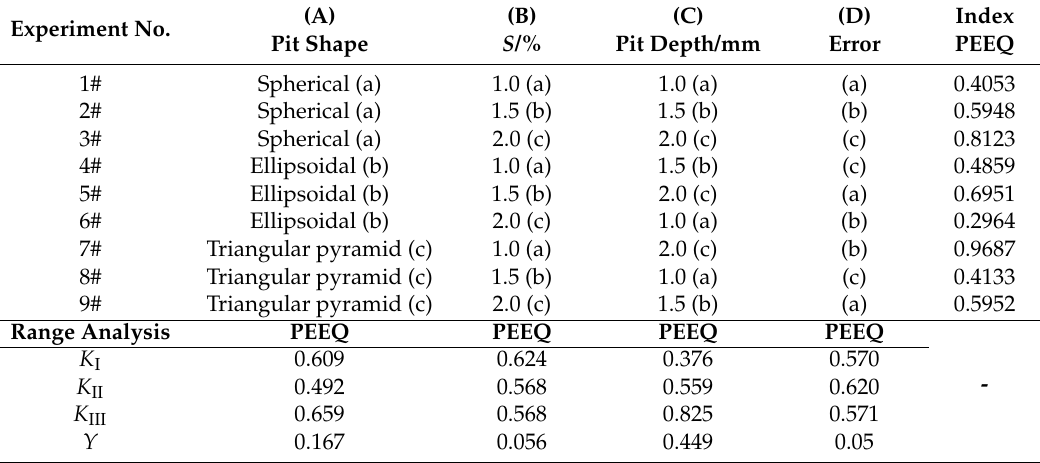
Table 6. Experimental arrangement and range analysis. PEEQ: Equivalent plastic strain. Experiment No.